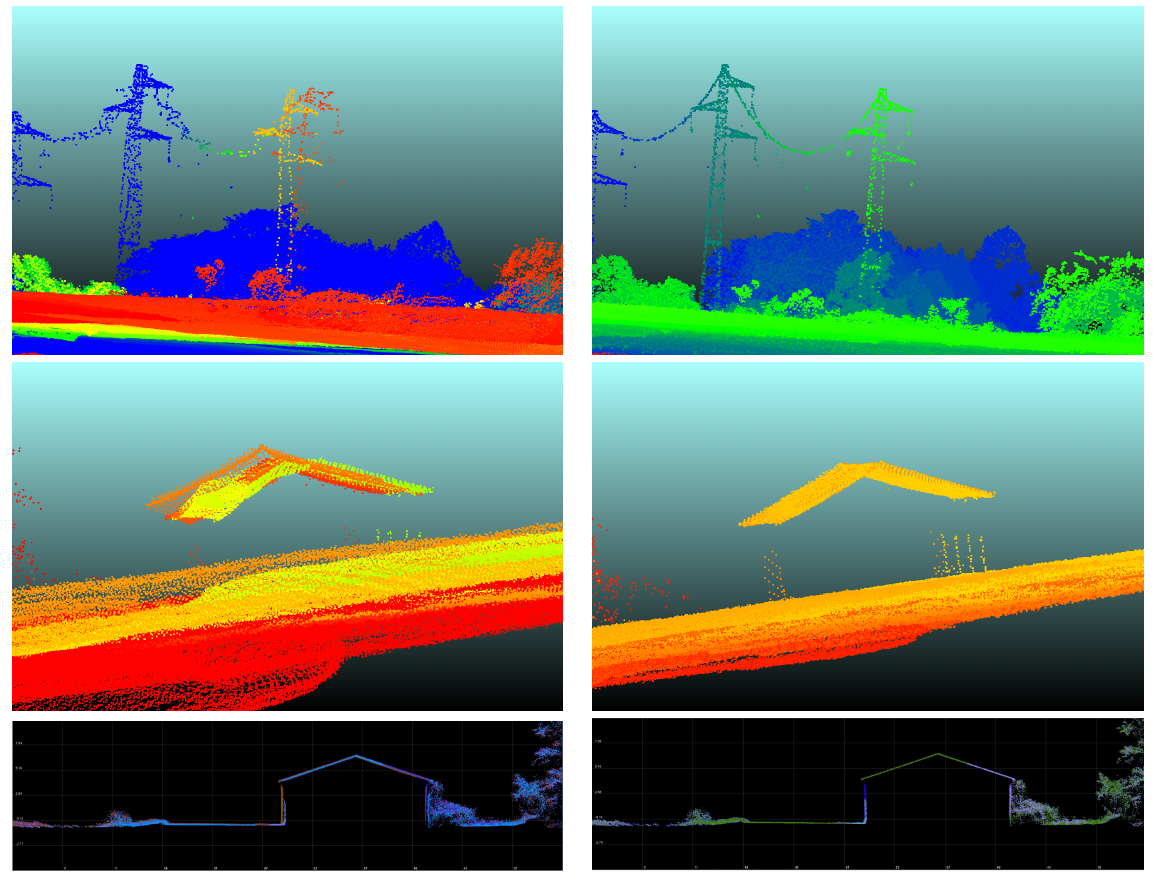
Figure 11. Riegl MiniVUX-DL LiDAR before ( left ) and after ( right ) LIBAC. The colors means the different flight